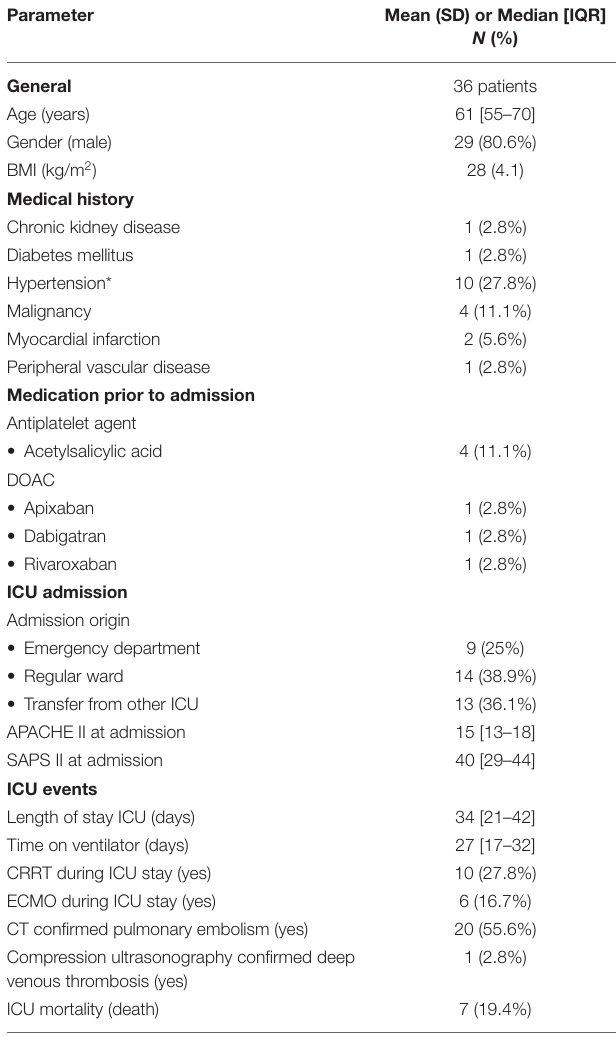
TABLE 1 | Baseline characteristics, ICU admission, and